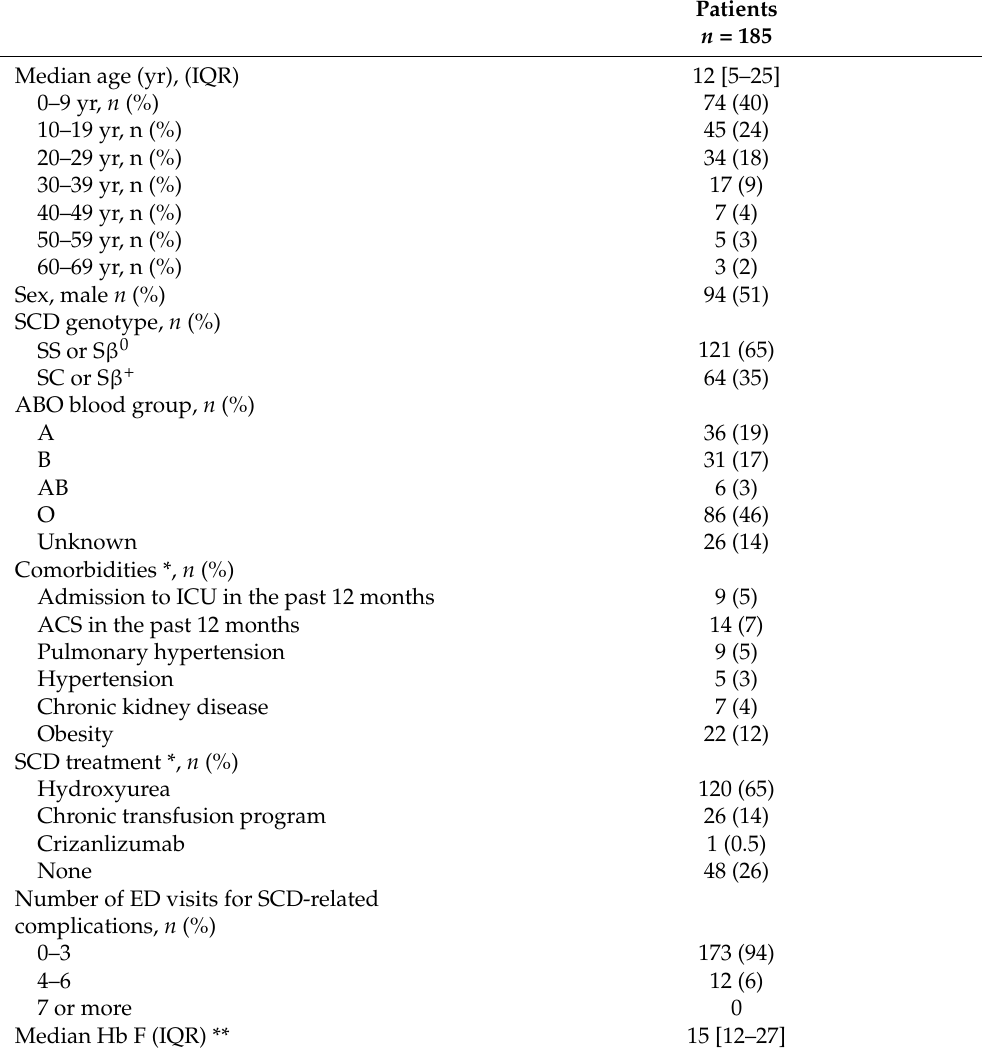
Table 1. Characteristics of SCD patients with a diagnosis of SARS-CoV-2 infection between